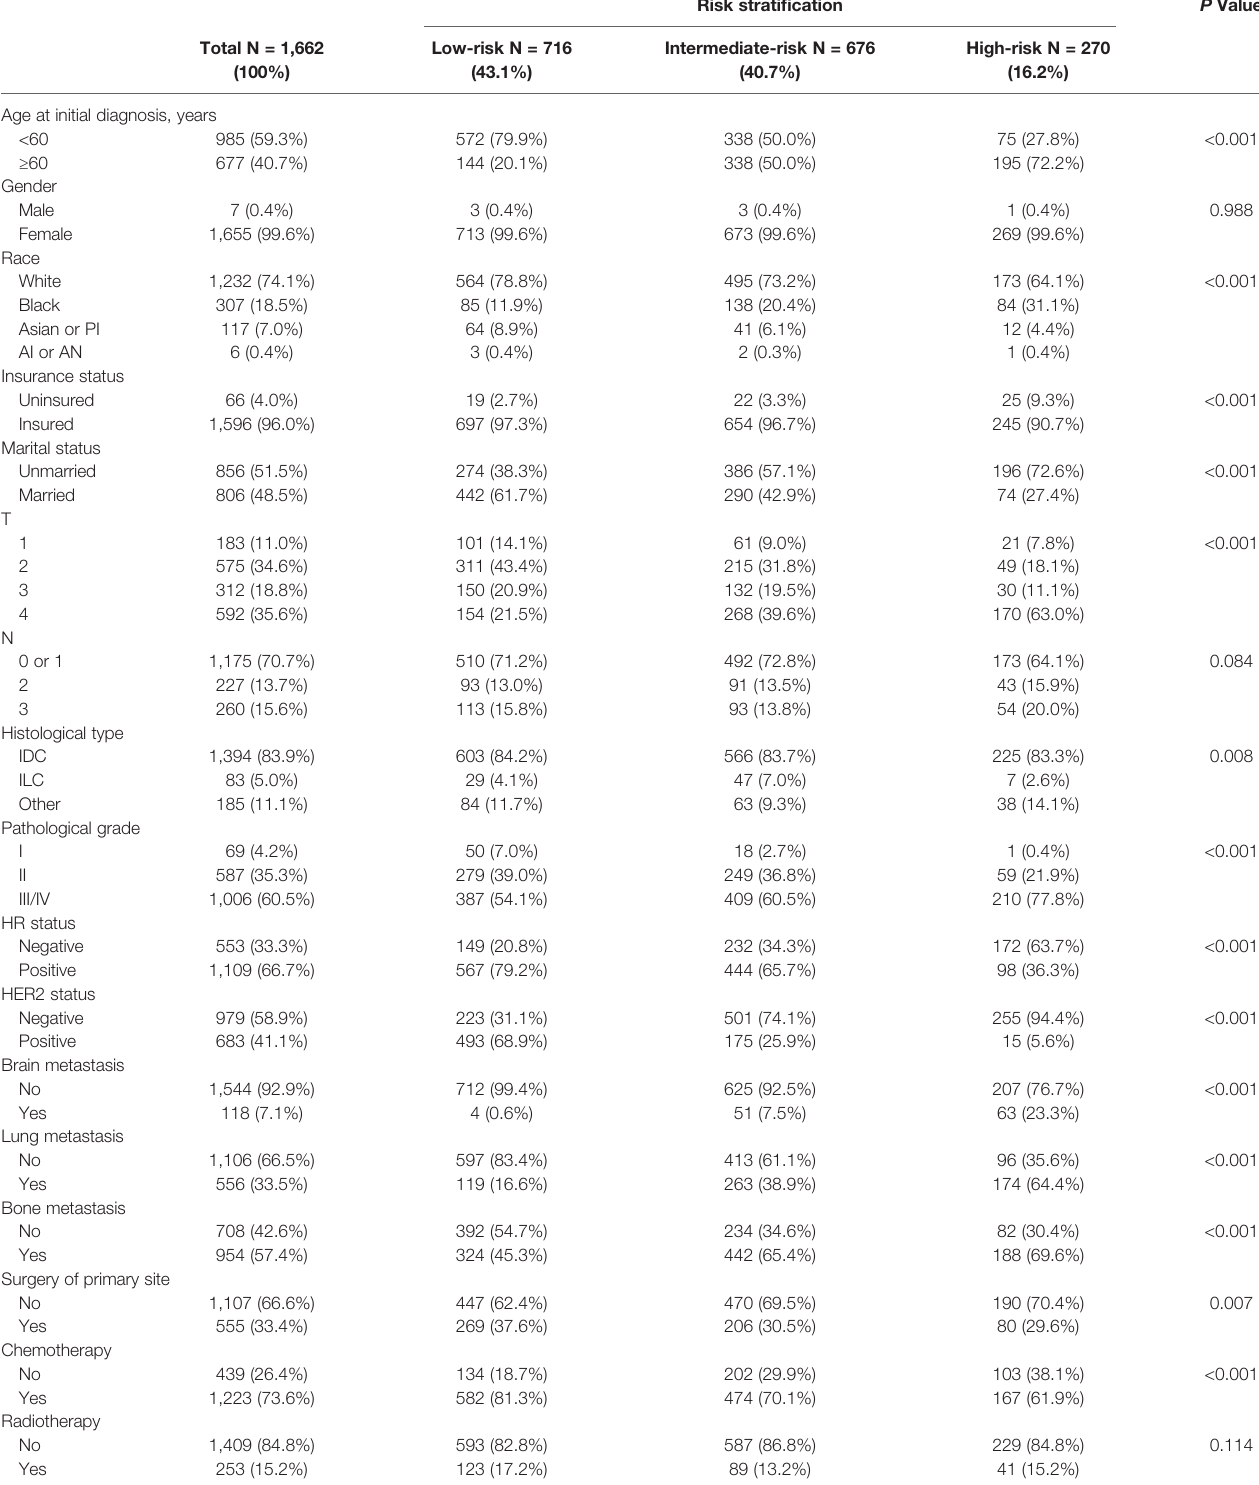
TABLE 1 | Characteristics of BCLM and risk strati fi cation in the training